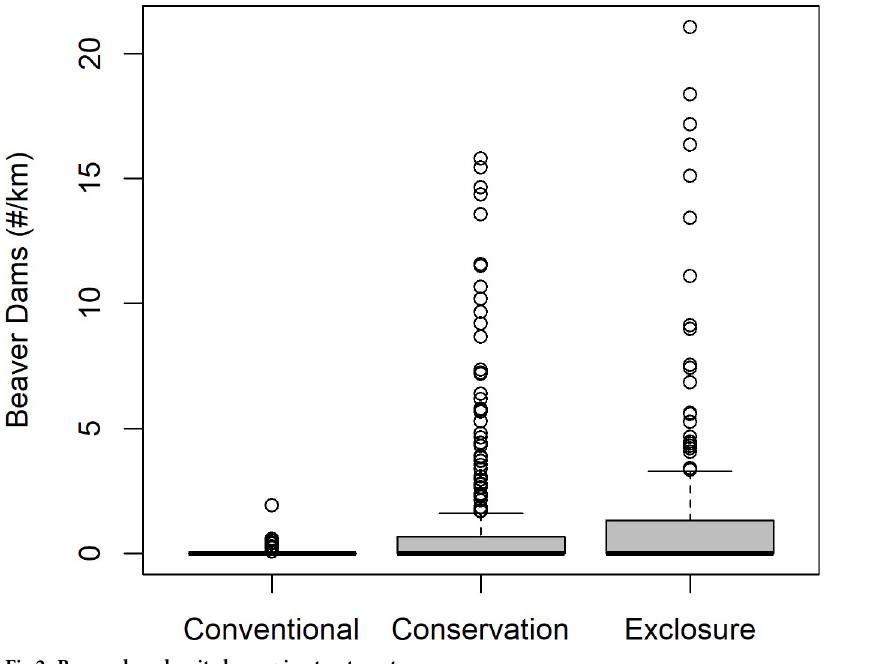
Fig 2. Beaver dam density by grazing treatment.